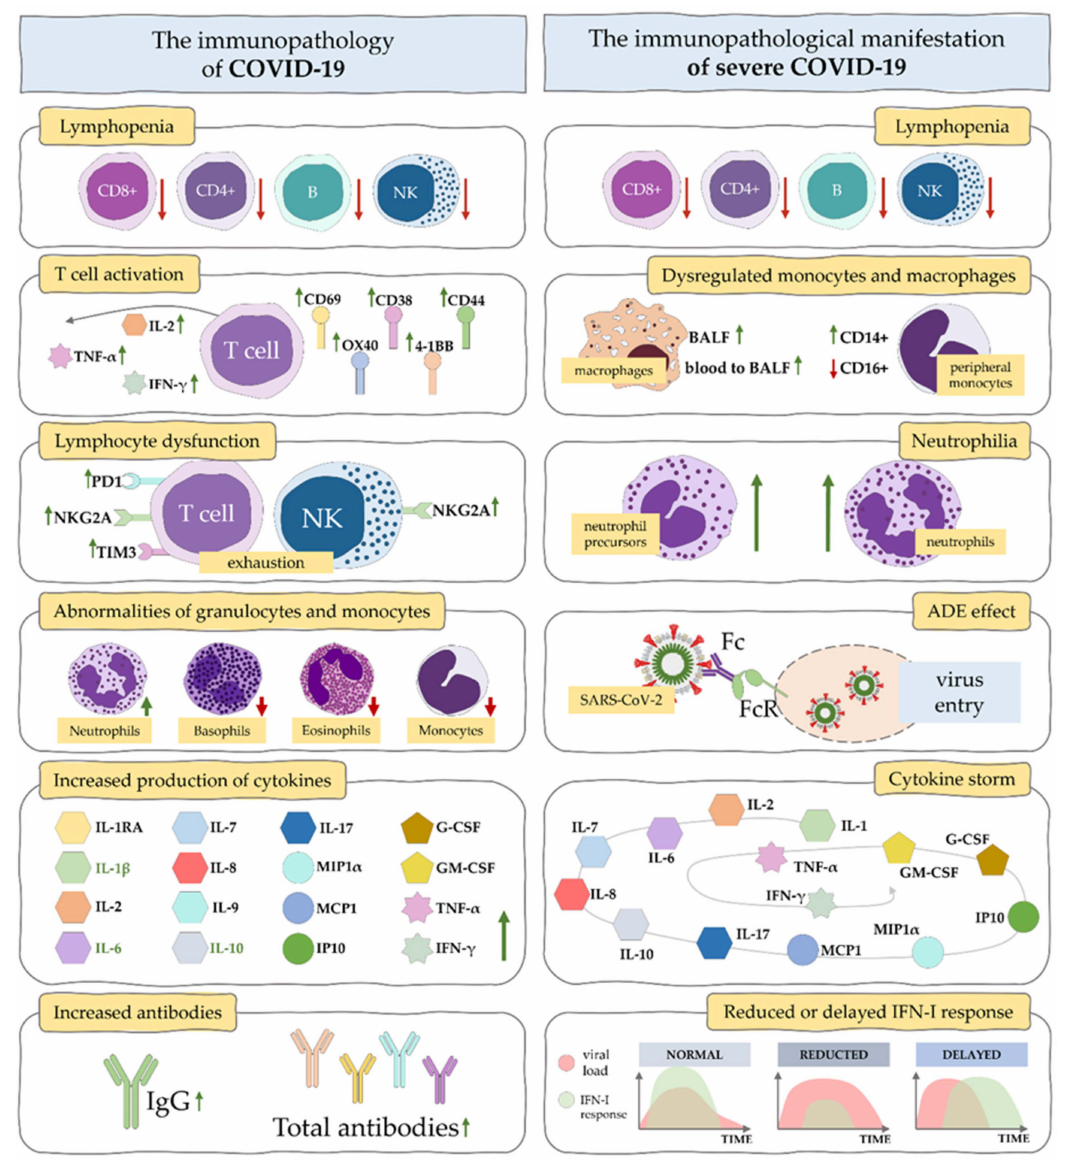
Figure 3. The immunopathology of mild and moderate COVID-19 and immunopathological manifes- tation of severe